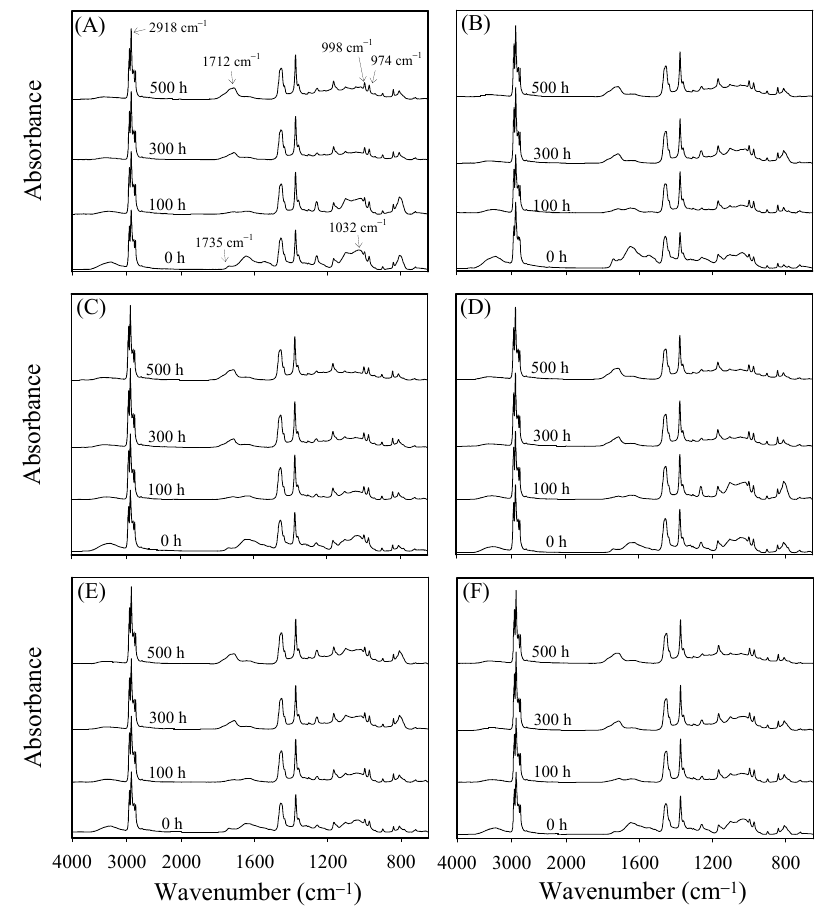
Figure 4. ATR-FTIR spectra of various WPCs before and after xenon arc accelerated weathering for 100, 300, and 500 h. ( A ) WPC B20 , ( B ) WPC R20 , ( C ) WPC S16 , ( D ) WPC S20 , ( E ) WPC S30 , and ( F ) WPC S60 .